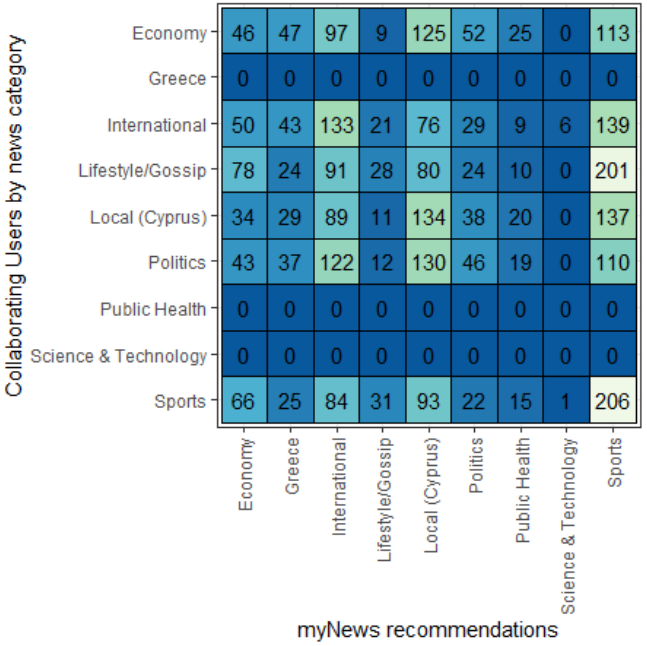
Figure 8. Matrix of frequencies of collaborating users.